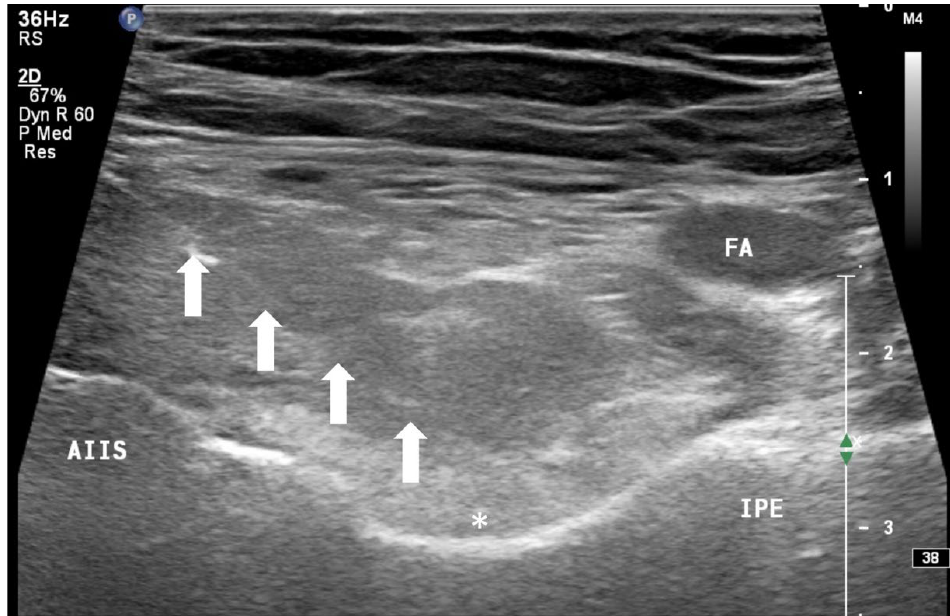
Figure 3. Ultrasound image showing injection of FNAB and AON by infiltration of the drug between the IPE and AIIS from lateral to medial (PENG approach). FA: femoral artery, AIIS: anterior inferior iliac spine, IPE: iliopectineal eminence, *: absolute alcohol spreading underneath iliopsoas muscle above the ASIS-IPE bone surface, white arrow: needle.